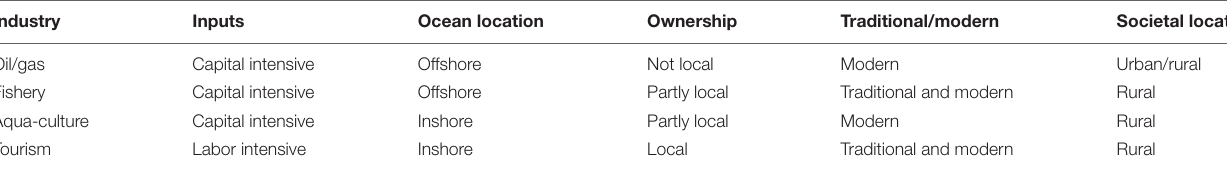
TABLE 1 | Industry scales.